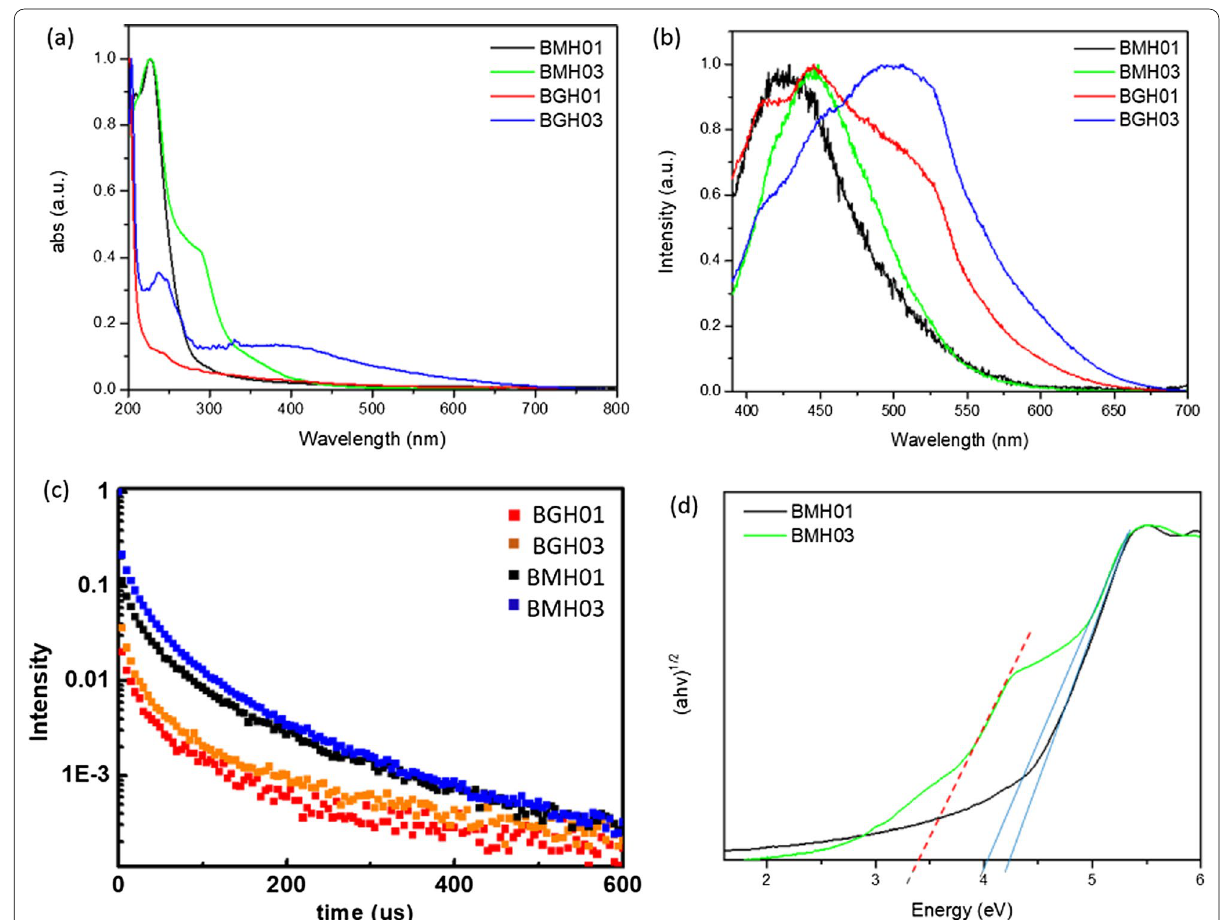
Fig. 6 a Overlay UV absorbance spectra of BMH01, BMH03, BGH01, and BGH03. b Stacked photoluminescence spectra of BMH01, BMH03, BGH01, and BGH03 upon excitation at 365 nm c stacked photoluminescence lifetime decay spectrum of BMH01, BMH03, BGH01, and BGH03 monitored at a predetermined λ max for each sample. Samples were excited with 337 nm laser pulses at 298 K, d Overlay Tauc plot (αhv) 1/2 vs. h v, for BMH01 (black trace) and BMH03 (green trace). The optical band gap is represented by thesolid line, while the interband state for BMH03 is represented by the red dashed